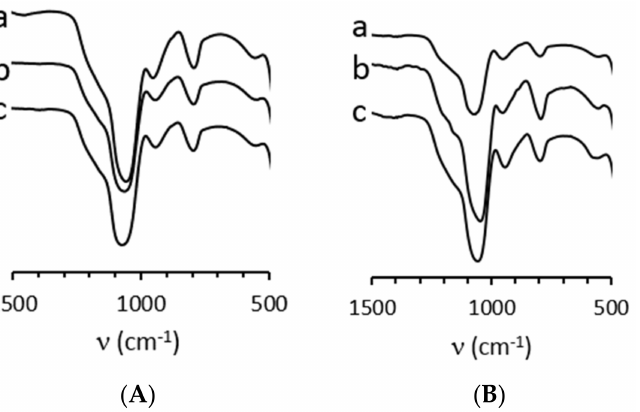
Figure 7. Relevant IR vibration zones for SiO 2 (a), SiO 2 @CN (b), SiO 2 @COOH (c) beads from SiO 2 beads produced in EtOH ( A ) and MeOH ( B ).